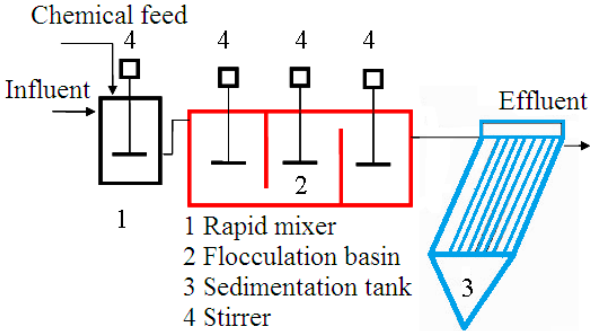
Table 2. Operational conditions of coagulation process.